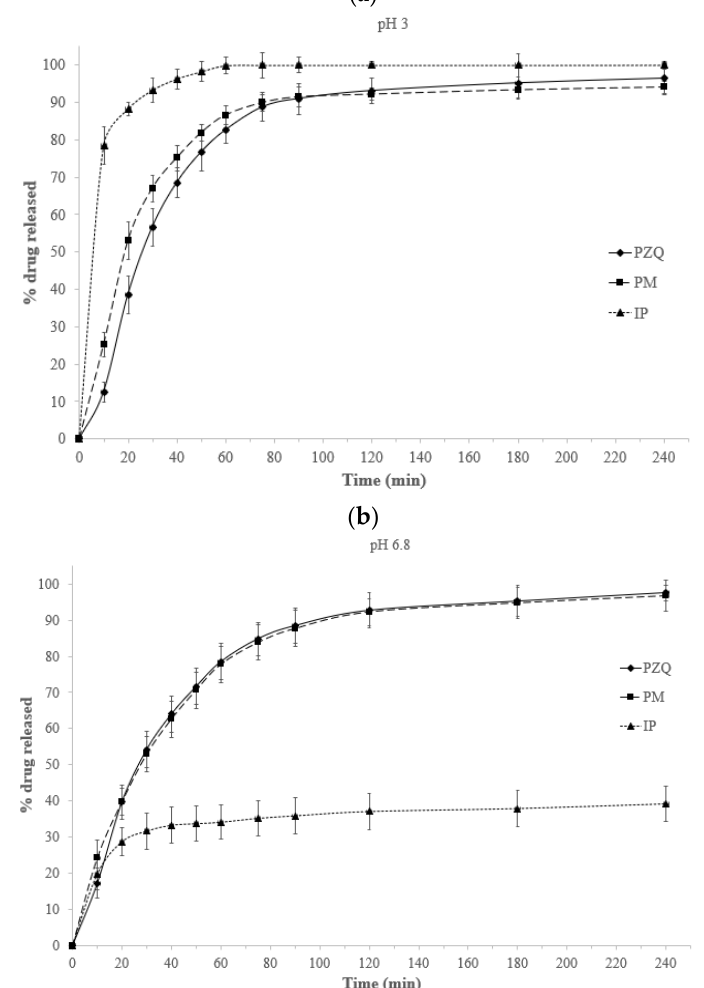
Figure 1. Drug release (% w / w ) profiles from the PZQ and the PM in 0.001 M HCl at pH = 3 ( a ) and in a SIF medium at pH = 6.8 ( b ) in sink conditions; (mean values ± standard deviation; n = 5).